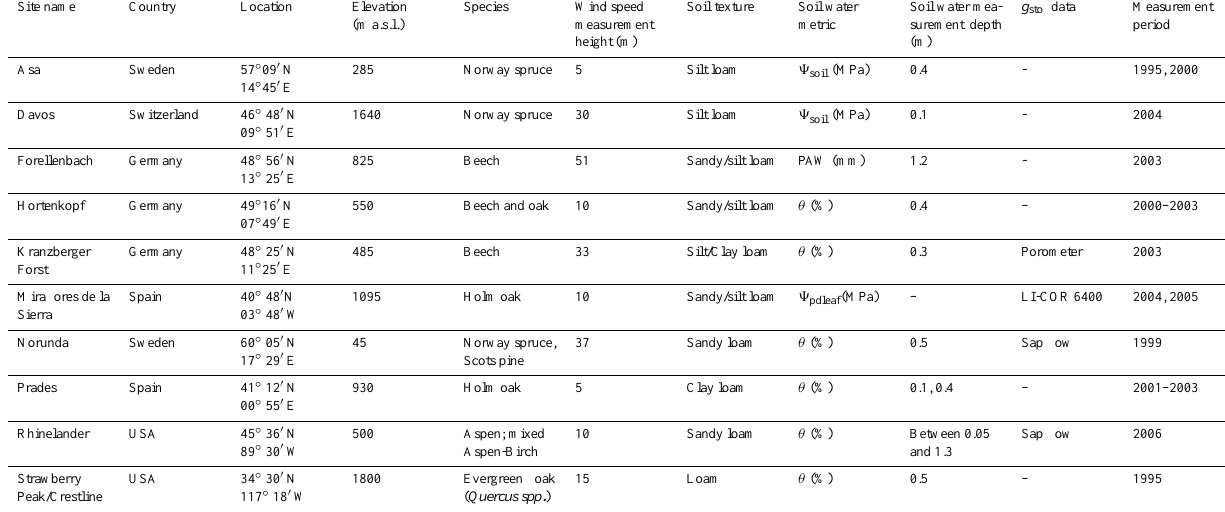
Table 4. Forest datasets used to test soil water status estimates of the DO 3 SE model. References as in Table 2.